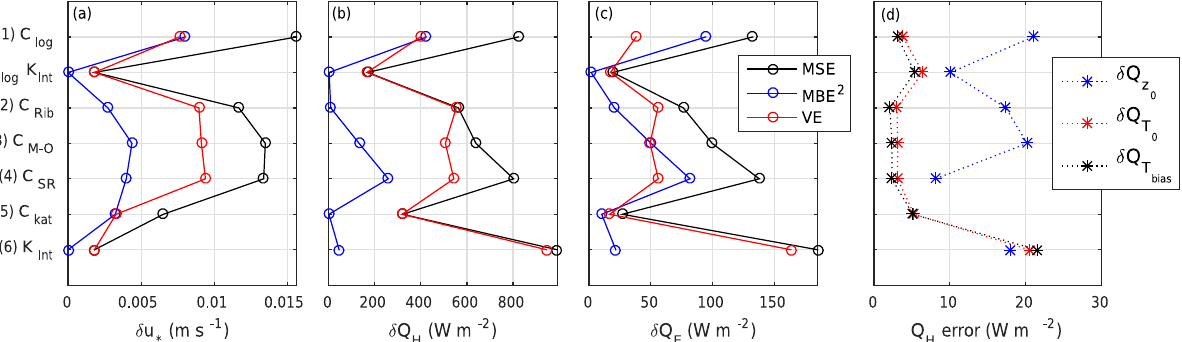
Figure 12. (a–c) Mean square error (MSE), squared mean bias error (MBE 2 ), and variance error (VE) for the six main bulk methods and the “hybrid” C log K Int bulk method, for the 2012 dataset. Note that MSE = MBE 2 + VE. (d) Error in Q H for each bulk method is due to (cid:1) ; and (3) the (cid:1) ; (2) the assumption that the surface temperature is at melting point (cid:0) δQ (1) the uncertainty in the roughness lengths (cid:0) δQ z T 0 0 (cid:1) . systematic error in air temperature due to radiative heating of the temperature sensor (cid:0) δQ T bias